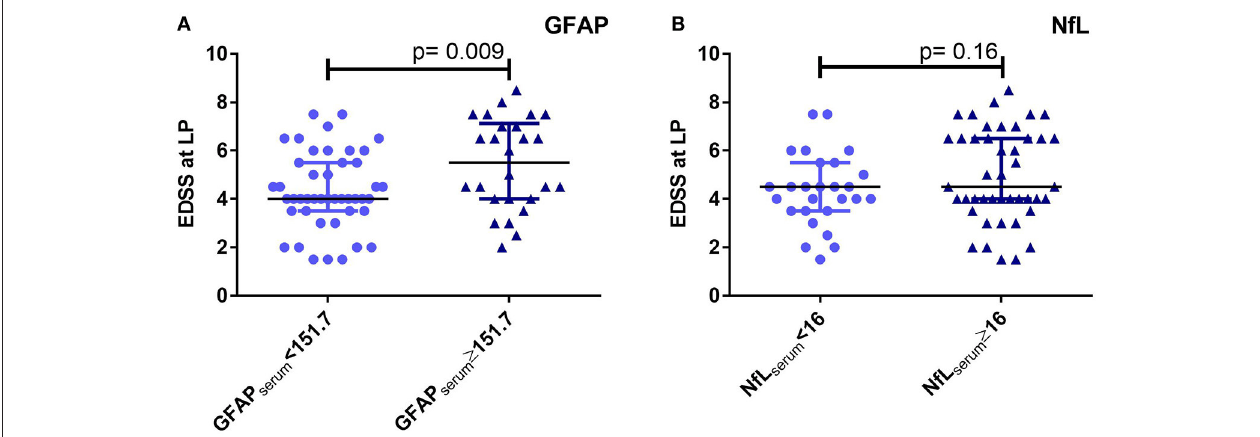
FIGURE 4 | Comparison of expanded disability status scale (EDSS) values for primary progressive multiple sclerosis (PPMS) patients below and above cut-offs of 151.7 pg/ml for glial fibrillary acidic protein (GFAP) (A) and 16 pg/ml for neurofilaments light chain (NfL) (B) in serum (Mann-Whitney U test), respectively. There was a significant age difference for the grouping by NfL but not for GFAP (Mann-Whitney U test, p = 0.01 and 0.47, respectively). LP, lumbar puncture.